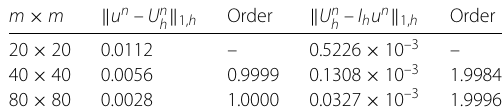
Table 2 Numerical results at t = 0.5 with τ = 5 h